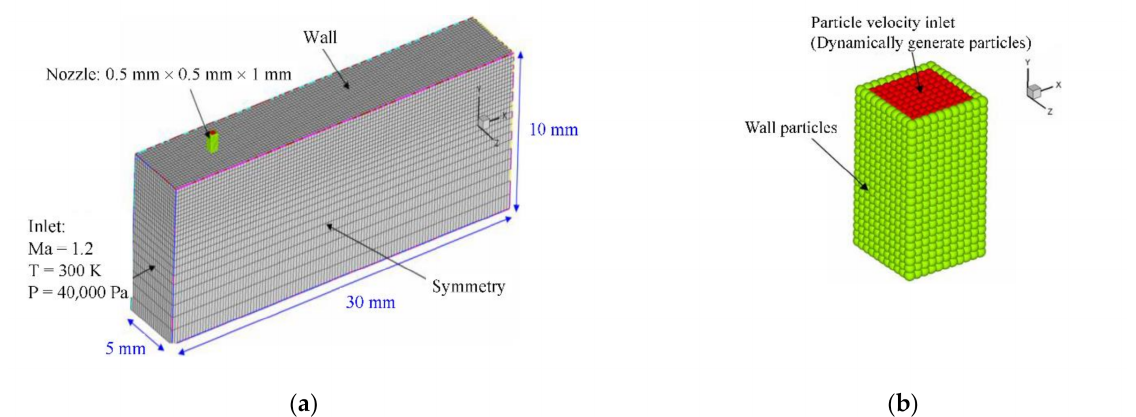
Figure 13. Grid and boundary conditions of the jetting liquid water in the static gas flow: ( a ) overall mesh and boundary conditions; ( b ) MPS boundary conditions of the